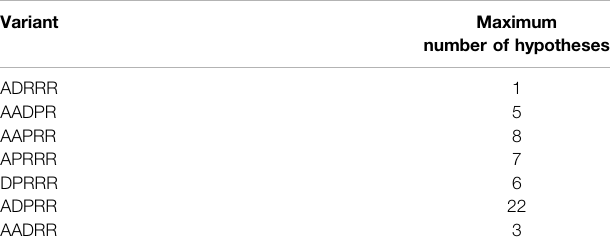
TABLE 2 | Selected and desired variants fi nding common pharmacophore for the variants among the given active ligands, 7 out of 7 selected variants can be seen in the variants ’